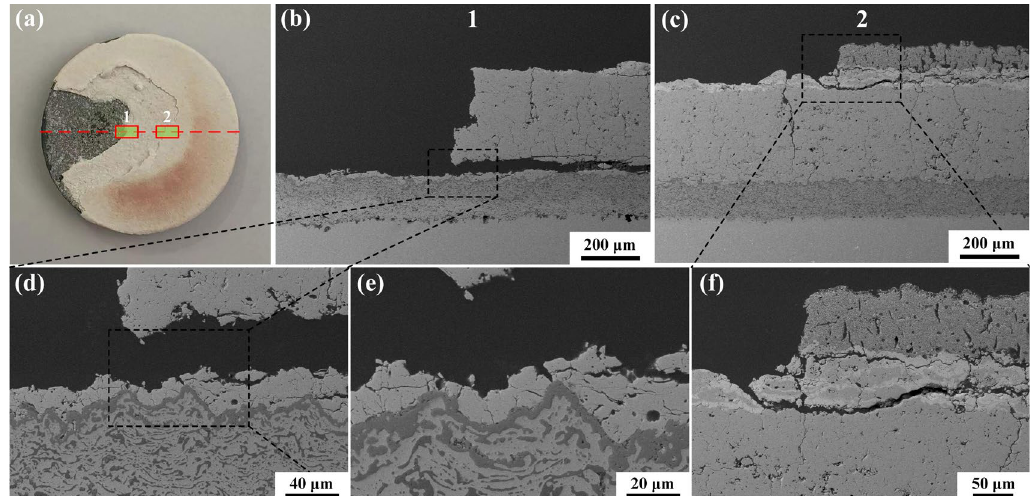
Figure 13. Thermal stress (S22) distribution along coating thickness in TBC system with two kinds of TC design after quenching.